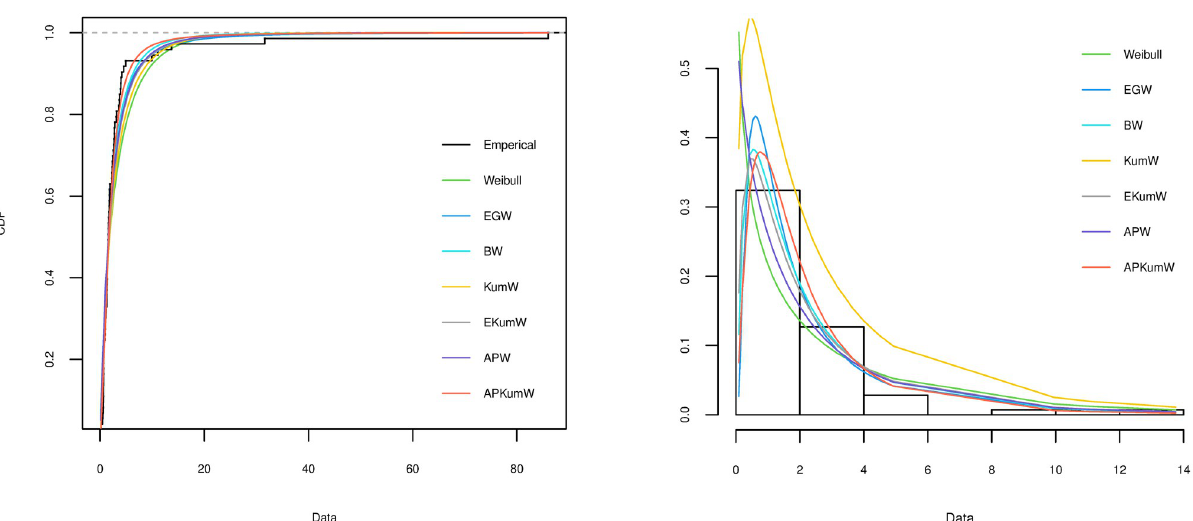
Figs 2–6 display on lefts the empirical and the fitted cdfs, and on rights the fitted pdfs with his-